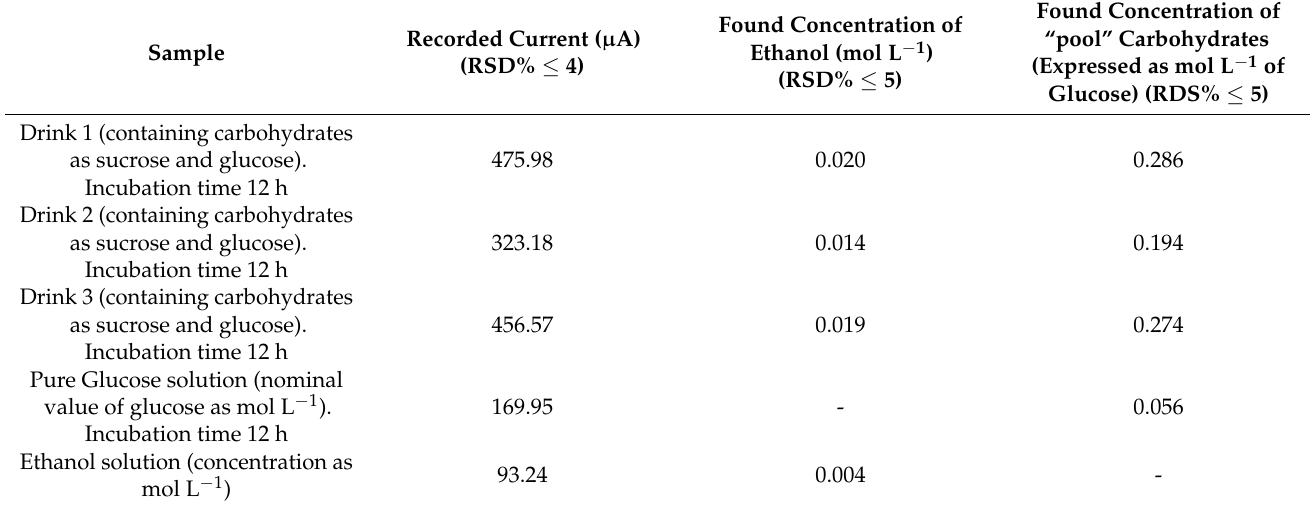
Table 2. Analytical results of three analyzed drinks containing carbohydrates compared to standard solutions of glucose and